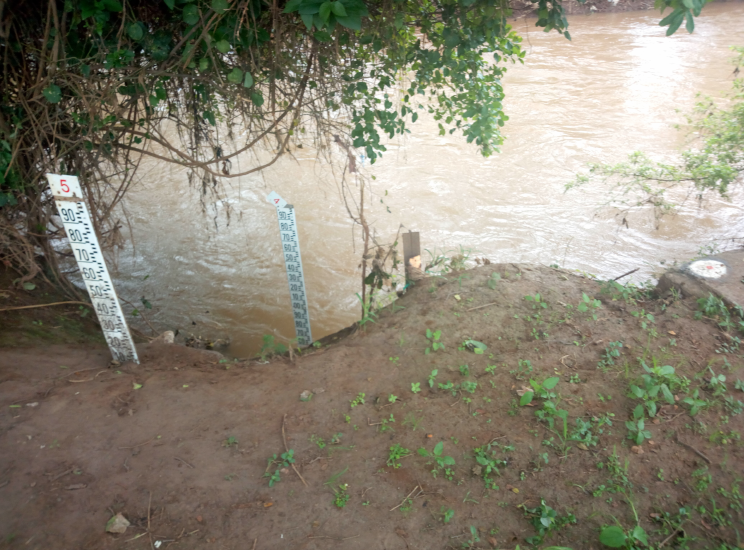
Figure 2. Water level staff